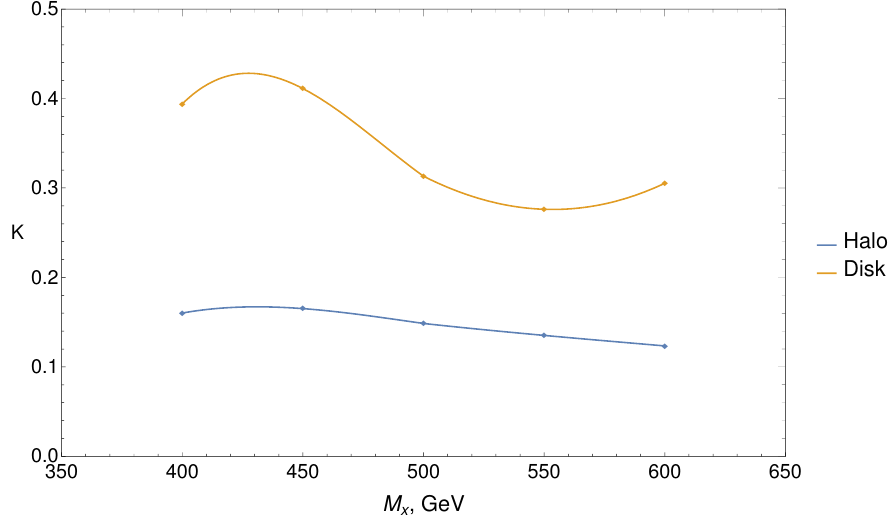
Figure 1. The suppression coefficient K in dependence of mass of initial dark matter (DM)